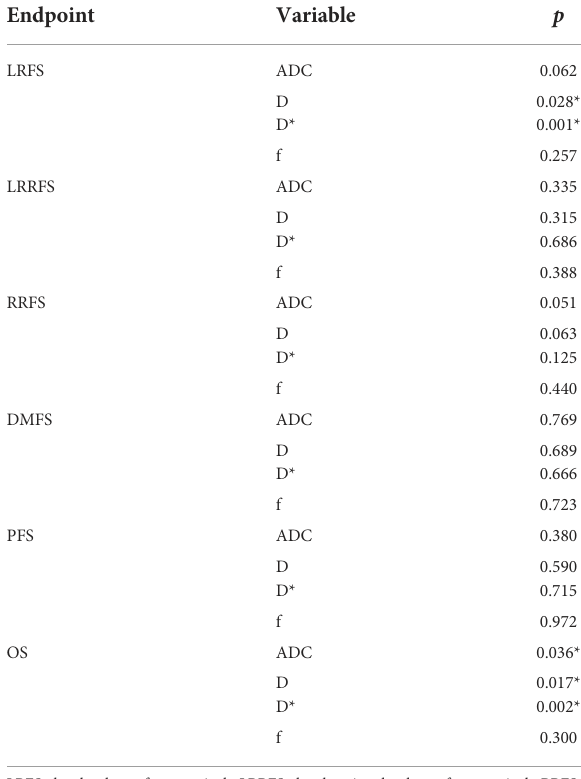
TABLE 3 Univariate analyses of the prognostic factors in the 97 patients with nasopharyngeal carcinoma.